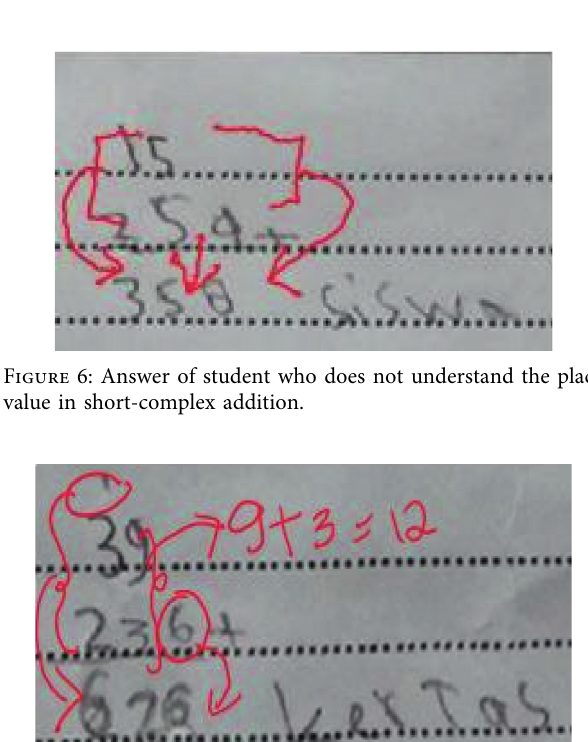
Figure 5: Student’s short-complex subtraction that does not match the place value.